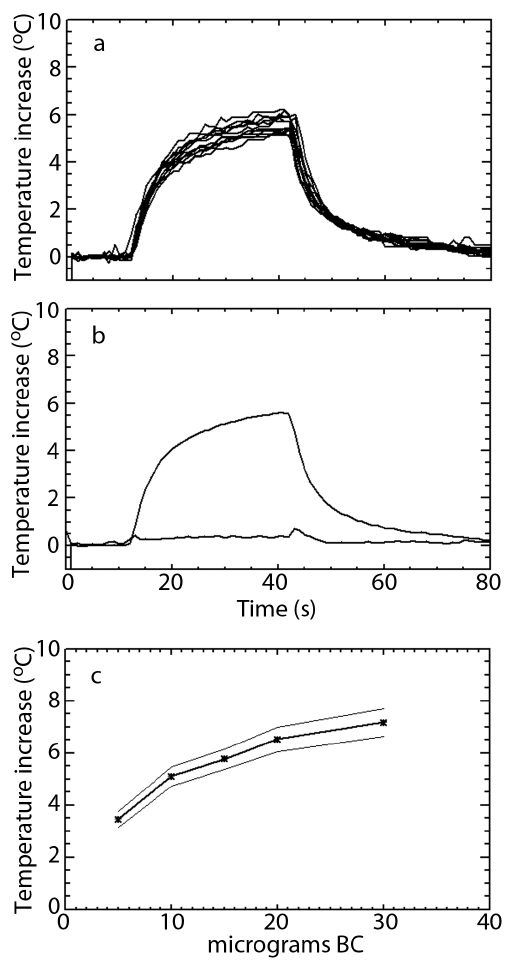
Figure 3. (a) Twelve temperature profiles measured for filters with 10µg of fullerene soot. Profiles are from three different filters mea- sured 4 times each. (b) Mean temperature profile and standard de- viation for 12 temperature profiles shown in (a) . (c) Temperature increases after 10s for five masses of fullerene soot. Error bars are standard deviations for each measurement and bold line is fit to